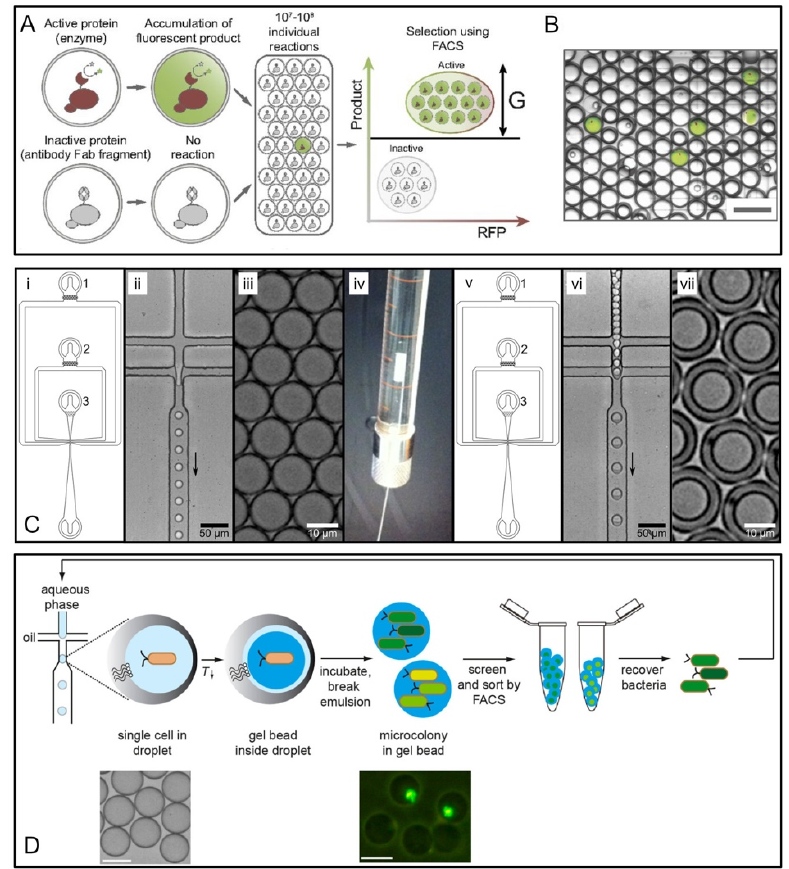
Figure 3. Flow cytometric sorting workflow using either double emulsion or hydrogel encapsulation. ( A , B ) Screening of biocatalysts anchored to the yeast surface using FACS on water-in-oil-in-water emulsions. ( A ) Compartmentalization of active and inactive yeast cells with fluorogenic substrate. After the mixture of active and inactive cells was encapsulated, the fluorescent product accumulated solely inside the droplets with active cells, which were selected using FACS. ( B ) Visualization of biochemical reaction by merging the signals of green fluorescence (reaction product), red fluorescence (reporter protein), and the visible light image. (Scale bar, 100 µ m.) Figure 3A,B were adapted from Reference [29], complying with the License for PNAS Articles. ( C ) Formation of double emulsion droplets using a two-chip system. (i) Design of the device for primary emulsification; (ii) The aqueous samples are first mixed, then primary droplets are formed in the flow-focusing junction; (iii) Image of the monodisperse water-in-oil droplets; (iv) The emulsion droplets are taken up in a syringe, overlaid with mineral oil, and cushioned with a bottom layer of fluorinated oil; (v) A device with identical design to the first emulsification device, but a hydrophilic coating is used for formation of secondary emulsions; (vi) Image showing the production of water-in-oil-in-water double emulsion; (vii) Image of the monodisperse double emulsion droplets. Figure 3C was adapted from reference [21] under the Creative Commons Attribution license. ( D ) Overview of the FACS screening method with hydrogel encapsulation. Single cells are encapsulated into monodisperse water-in-oil emulsion droplets. The aqueous solution contains agarose that gels upon cooling on ice. After the formation of monoclonal microcolonies inside the beads, the beads are recovered from the emulsion and sorted by FACS. The bacteria are recovered from the gel beads and are then ready for a further round of analysis. Bottom left: a phase contrast microscope image of droplets (bottom left). Bottom right: a fluorescence microscope image of beads with two of them containing a microcolony. Scale bars: 50 µ m. Figure 3D was adapted from reference [46] with permission from the American Chemical Society.